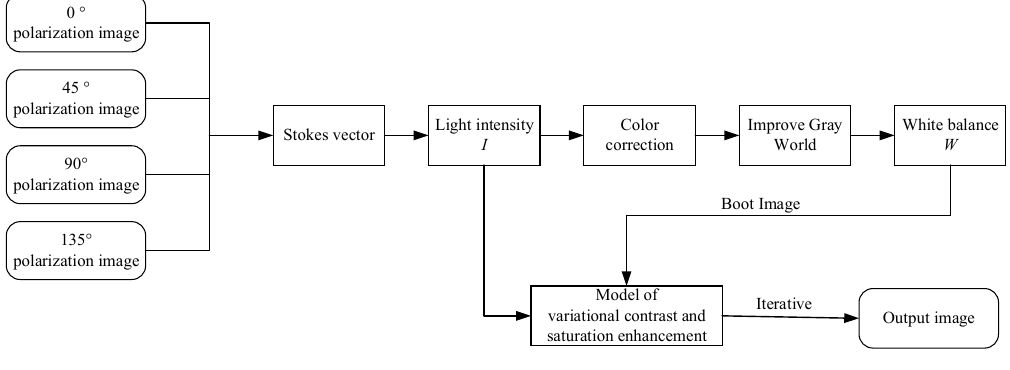
Figure 1. Algorithm flow chart.